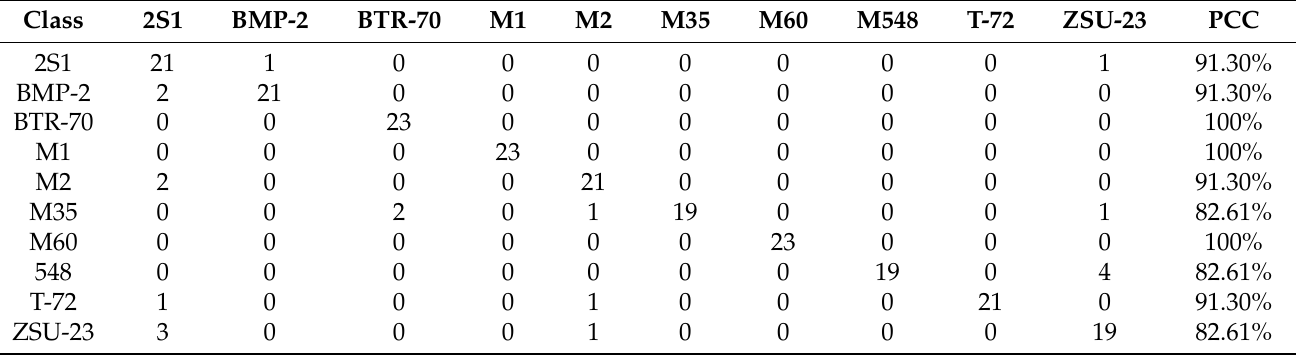
Table 5. Confusion matrix: Standard Operating condition (SOC), 400 Scattering Centers models, PIXEL extraction method, SCR-based approach, Modified Likelihood Ratio Test (MLRT), Global PCC = 91.30%.